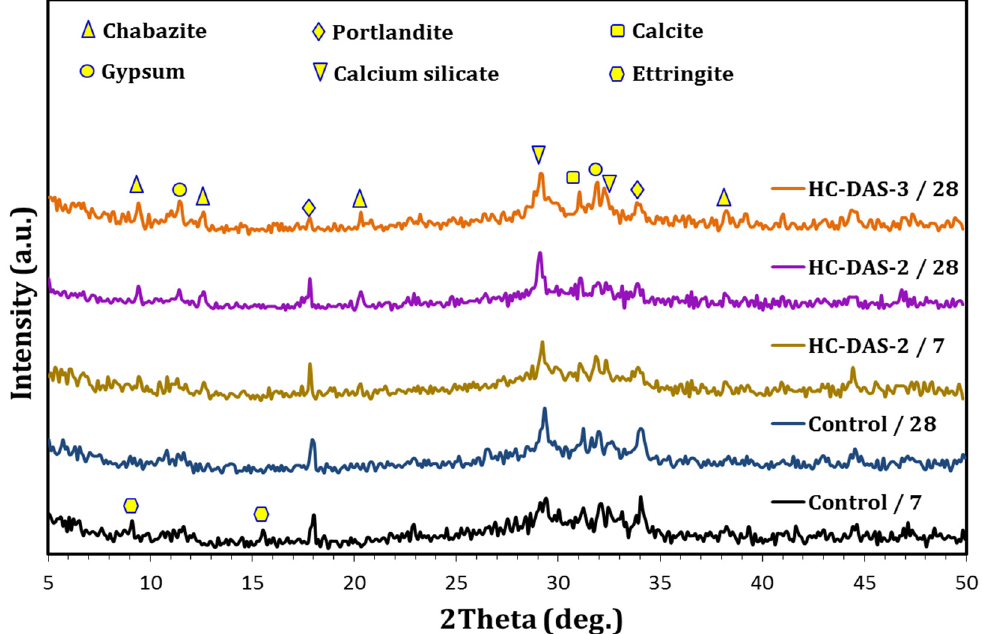
Figure 6. XRD patterns of the control sample and HC-DAS-2 pastes at 7 and 28 days as well as the HC-DAS-3 mixture at 28 days of curing.